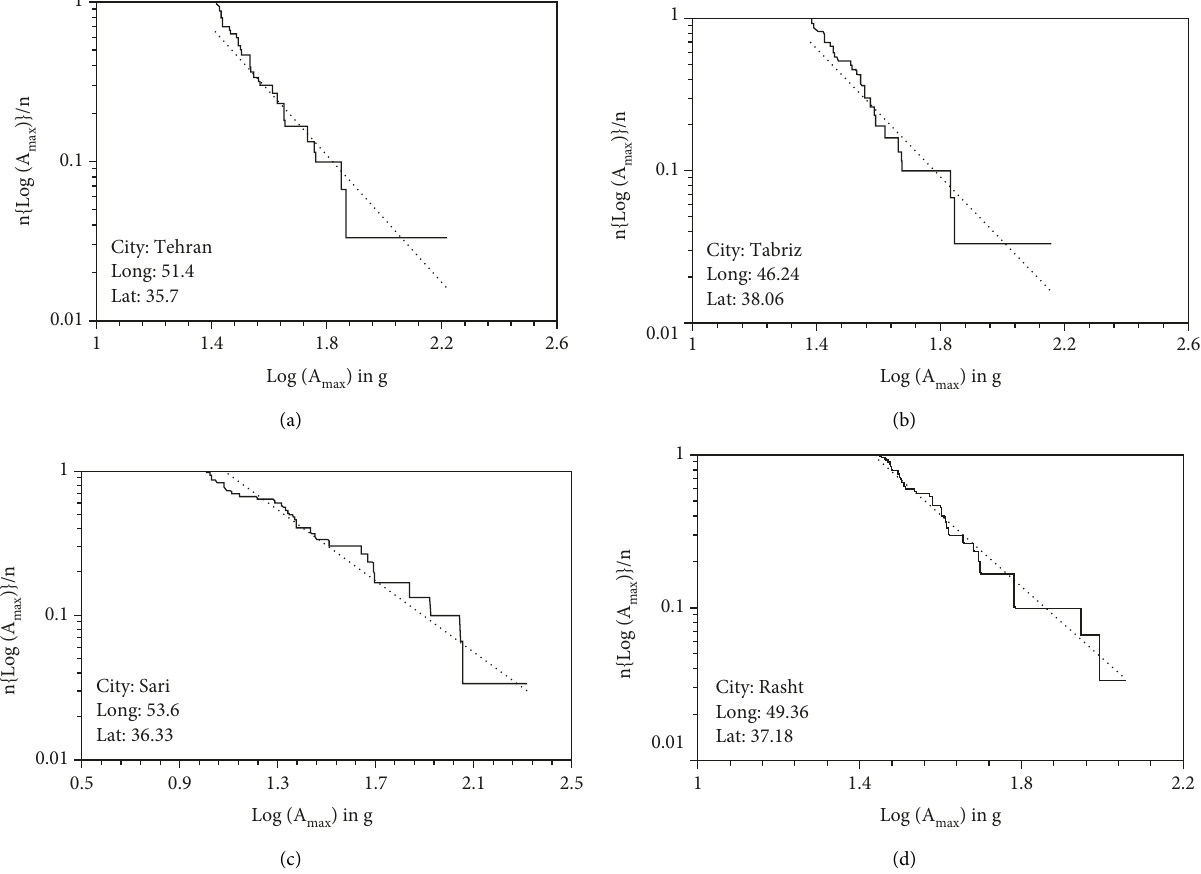
Figure 4: Empirical tail probability functions for log ( A station. (d) Rasht